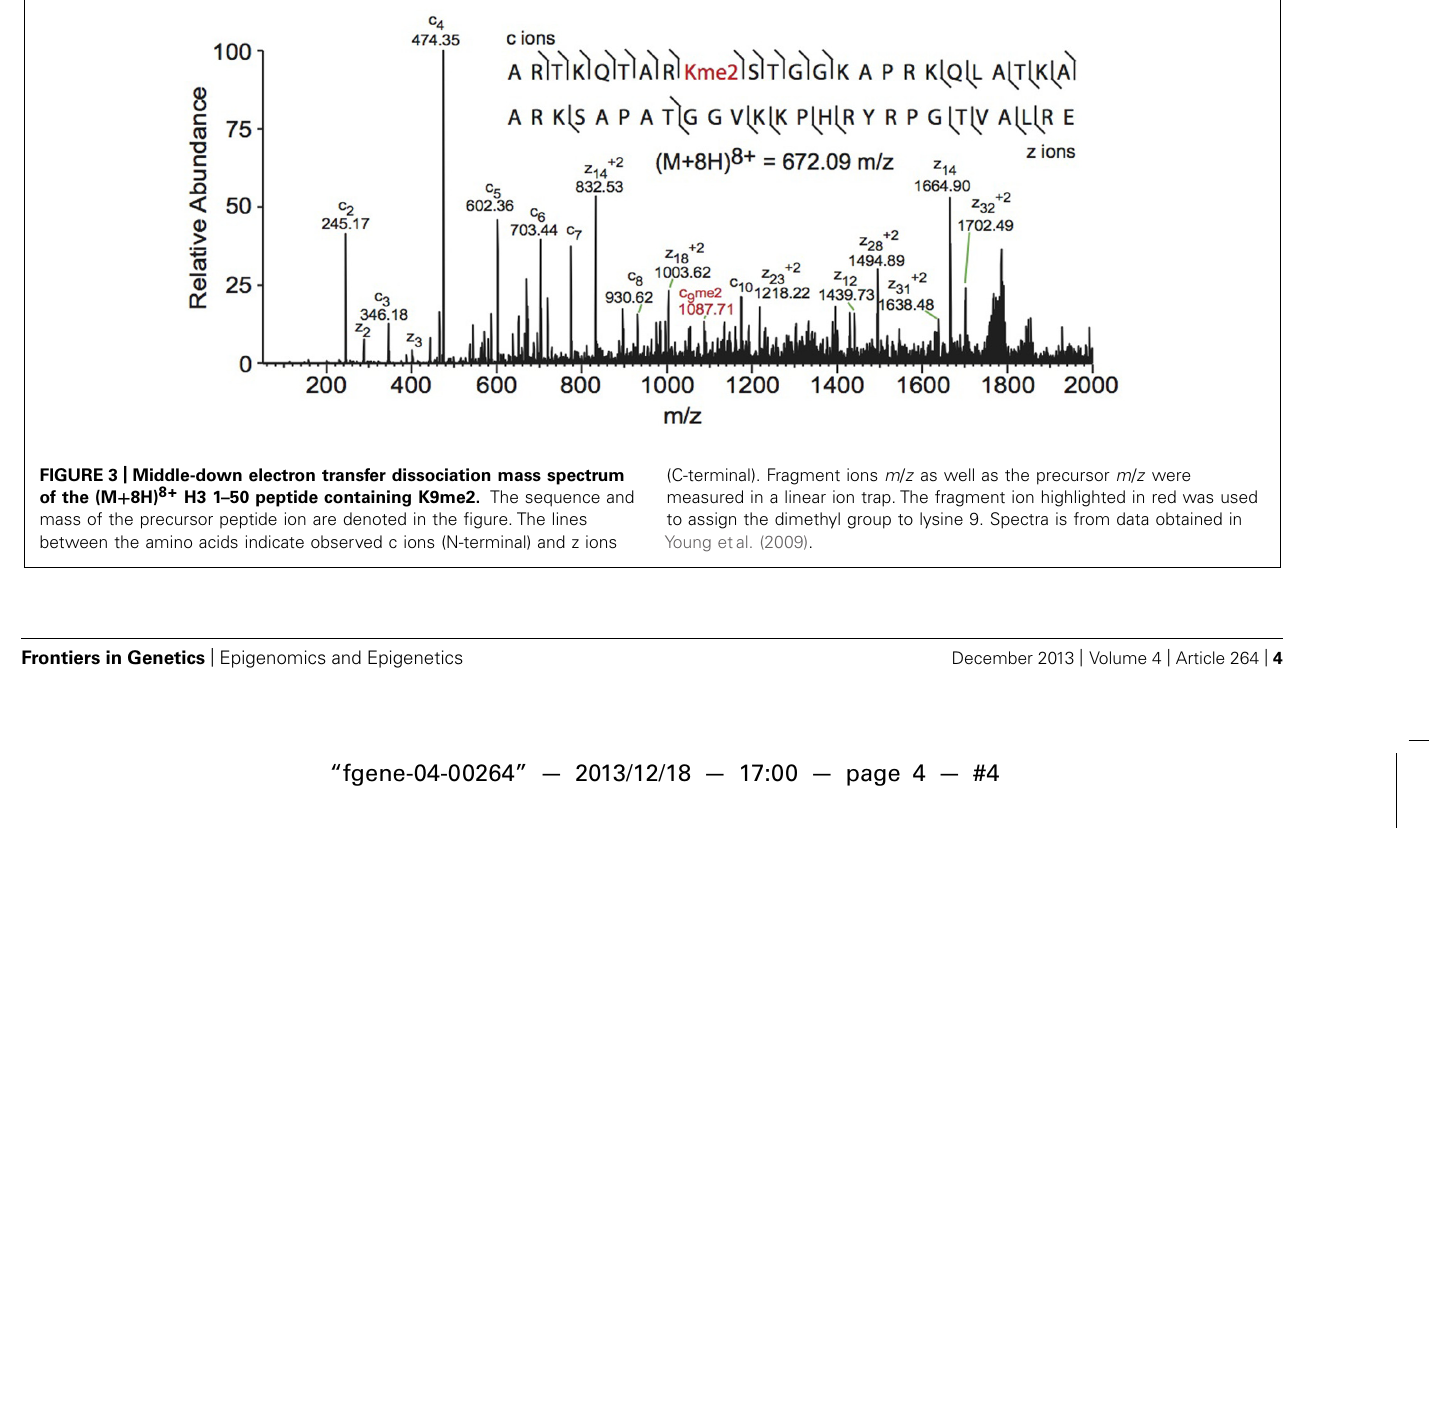
(C-terminal). Fragment ions m / z as well as the precursor m / z were measured in a linear ion trap. The fragment ion highlighted in red was used to assign the dimethyl group to lysine 9. Spectra is from data obtained in Young etal.